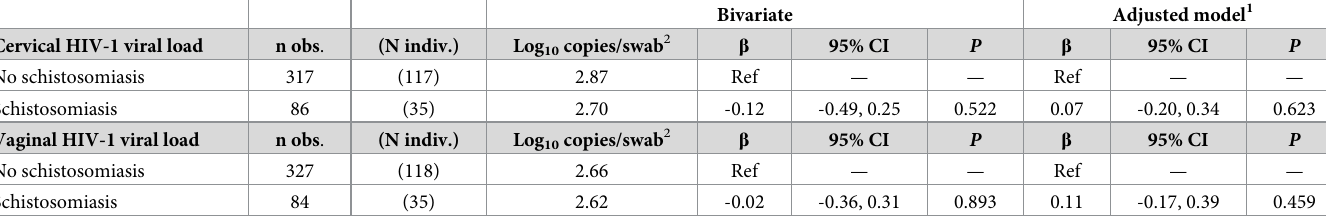
Bivariate Adjusted model 1